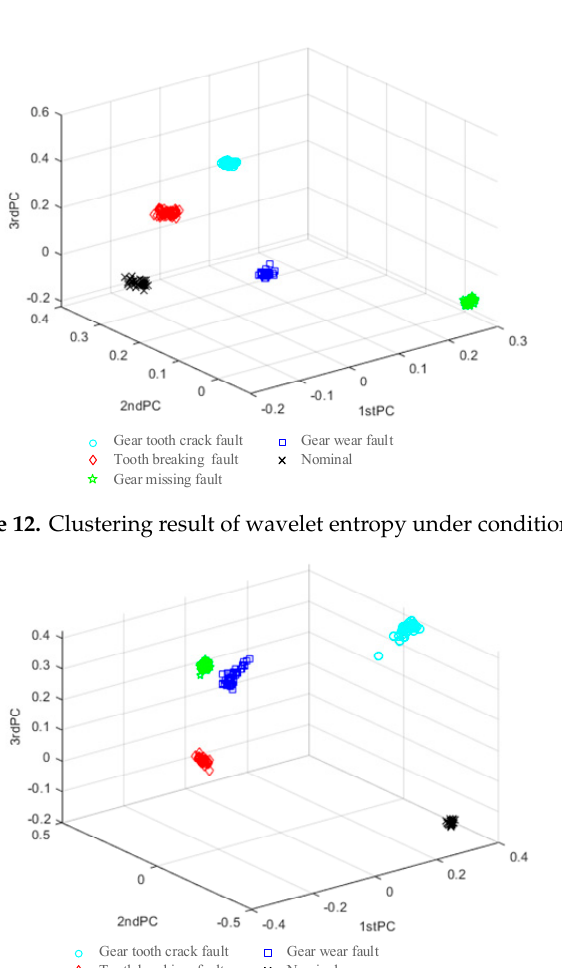
Figure 11. Clustering result of wavelet entropy under condition 1.